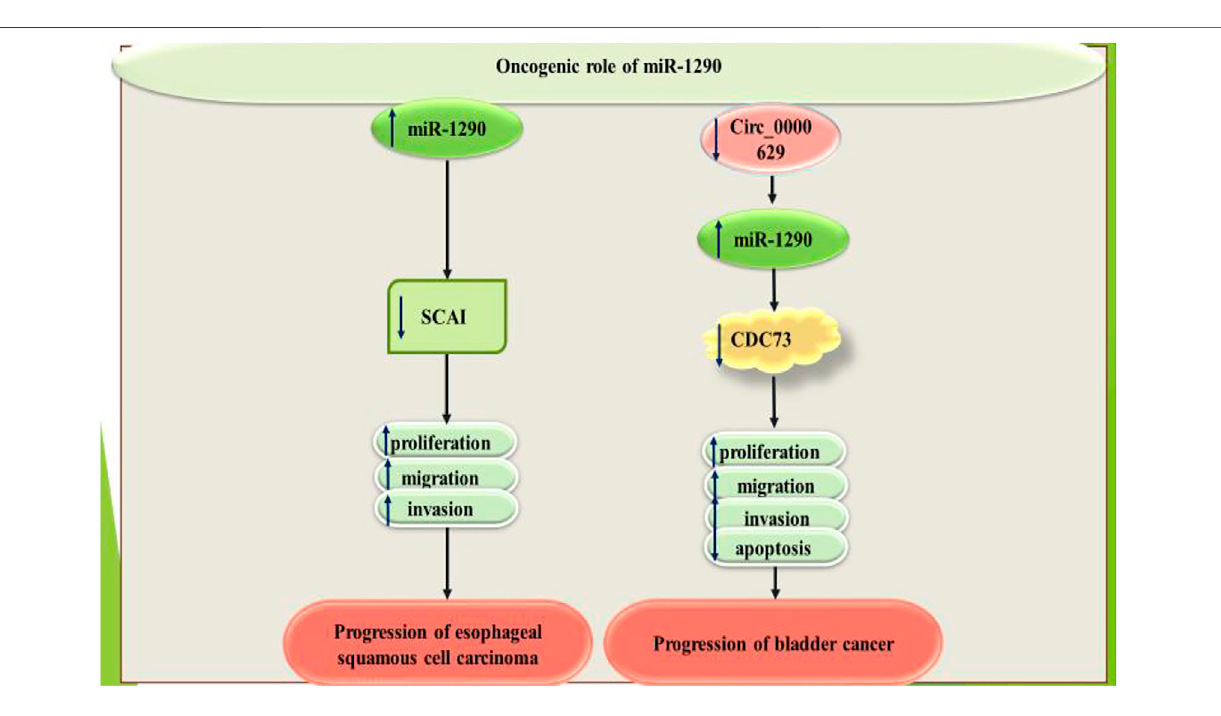
Frontiers in Molecular Biosciences |